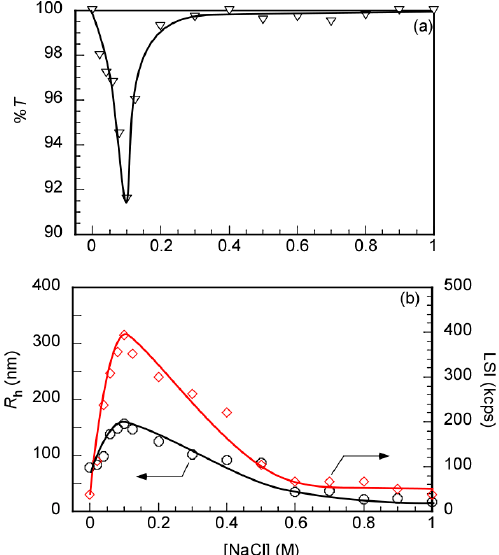
Figure 6. ( a ) Percentage transmittance (% T ), ( b ) hydrodynamic radius ( R h , black circles), and light scattering intensity (LSI, red diamonds) of aqueous PSBP/CTAB complex solutions as a function of [NaCl] at 25 °C.